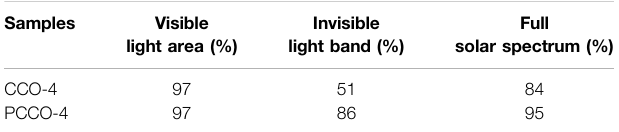
TABLE 1 | Light absorption ef fi ciency of carbonized cotton prepared under different pyrolysis conditions.